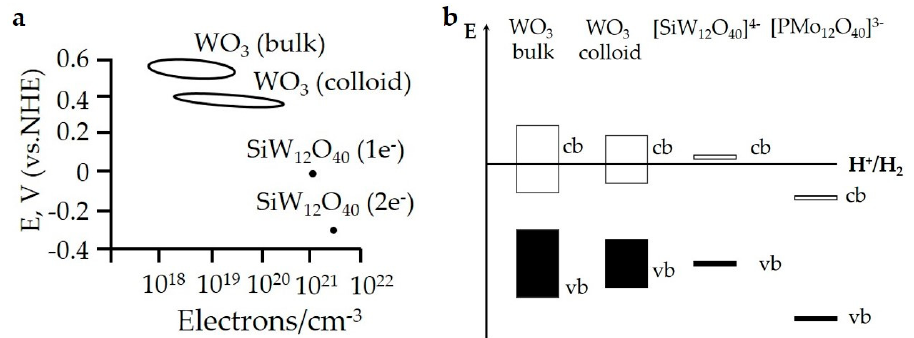
Figure 18. The effect of particle size on the flat band redox potentials ( a ) and schematic band structure diagram of POMs and WO 3 ( b ). Reprinted with permission from [88]. © 1997 2018 Elsevier BV.